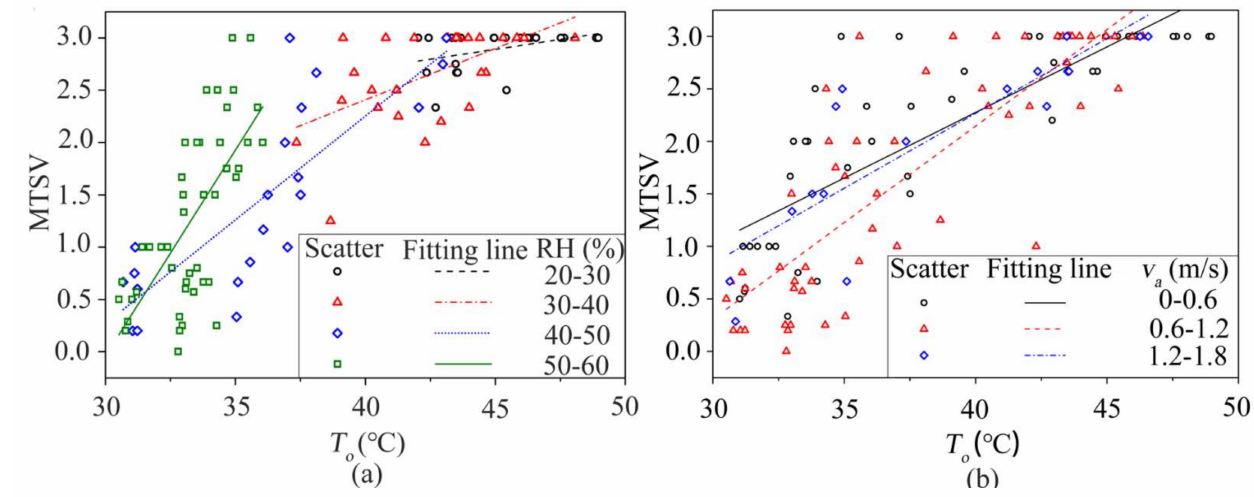
Figure 6. Relationship between T o and MTSV in different ( a ) RH or ( b ) v a .